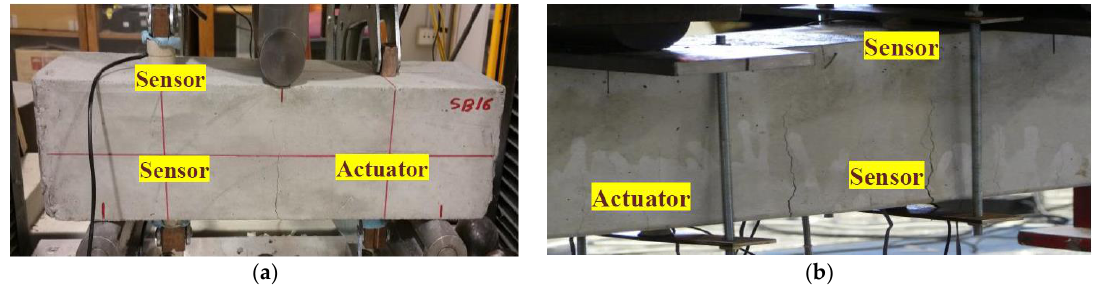
Figure 2. Bending test set up: ( a ) concrete, ( b ) RC beam.